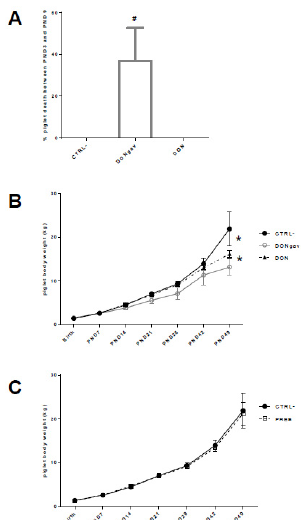
Figure 2. Sow performance. On left, comparison of control ( n = 4, CTRL, full circle) and PREB ( n = 4, PREB, empty square) groups and on right, comparison of CTRL and contaminated sows with DON ( n = 4, DON, full triangle). Normally distributed data were analyzed using a two-way ANOVA performing time, diet and the interaction between these two factors, followed by Tukey’s multiple comparison tests when appropriate Time e ff ect: a, b means with di ff erent letters are significantly di ff erent ( p < 0.05). ( A , D ) Sow body weight (kg) was recorded at 36 and 7 days before, and 14 and 28 days after parturition. ( B , E ) Back fat thickness (mm) was measured ultrasonically at 7 days before, and 14 and 28 days after parturition (significant di ff erence at (* p < 0.05) for CTRL and PREB). ( C , F ) Sow feed intake (kg) was recorded weekly from D + 7 to D + 28 after parturition.